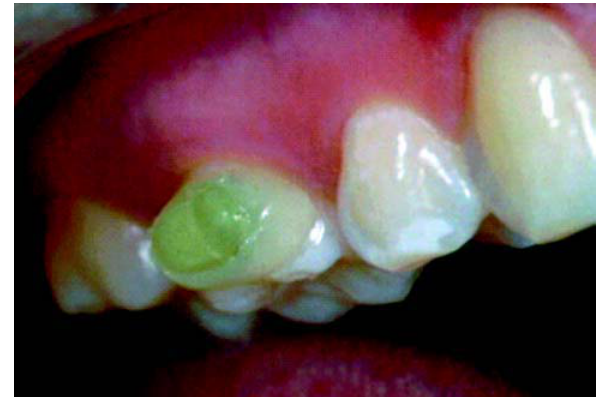
FIGURE 2- Original glass device attached to the buccal surface of the first upper right permanent molar